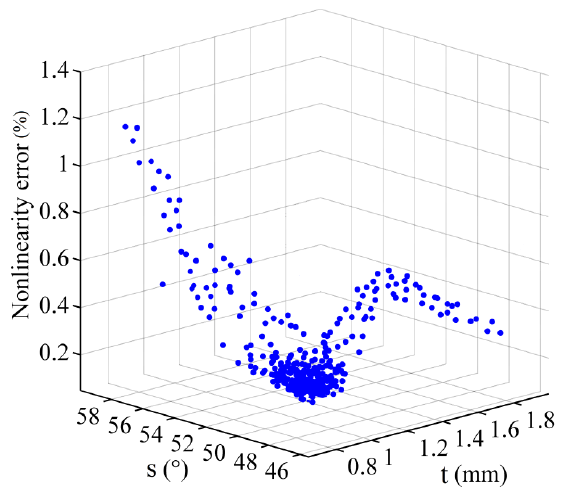
Figure 7 ． Nonlinearity error vs . the corresponding thickness and span obtained in the optimization design.